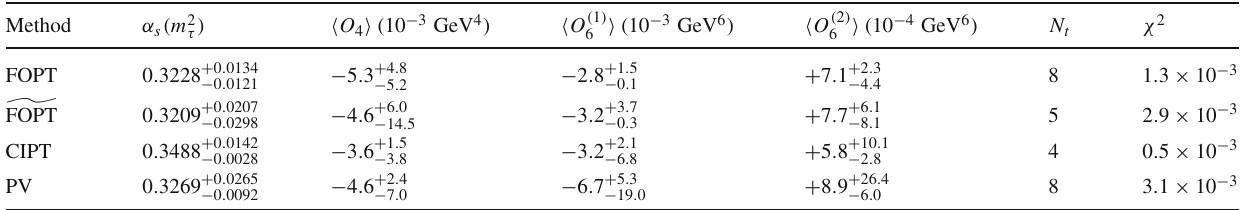
Table 3 The results for α s ( m 2 τ ) and the three condensates (of the full V + A channel) as obtained by the Borel–Laplace sum rule. Included are the optimal truncation numbers ( N t ) and the values of the fit